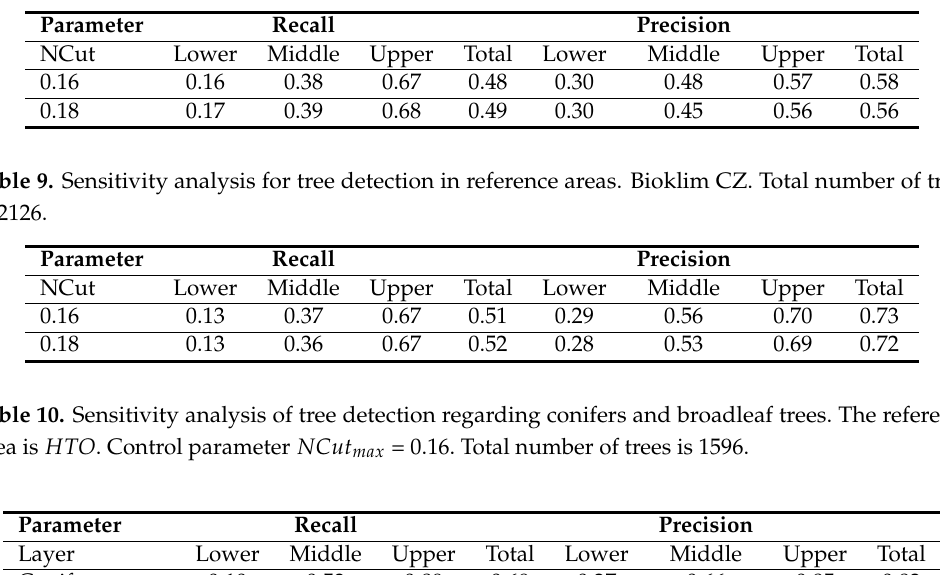
Table 8. Sensitivity analysis for tree detection in reference areas. HTO, Bioklim and LAI. Total number of trees is 5736.